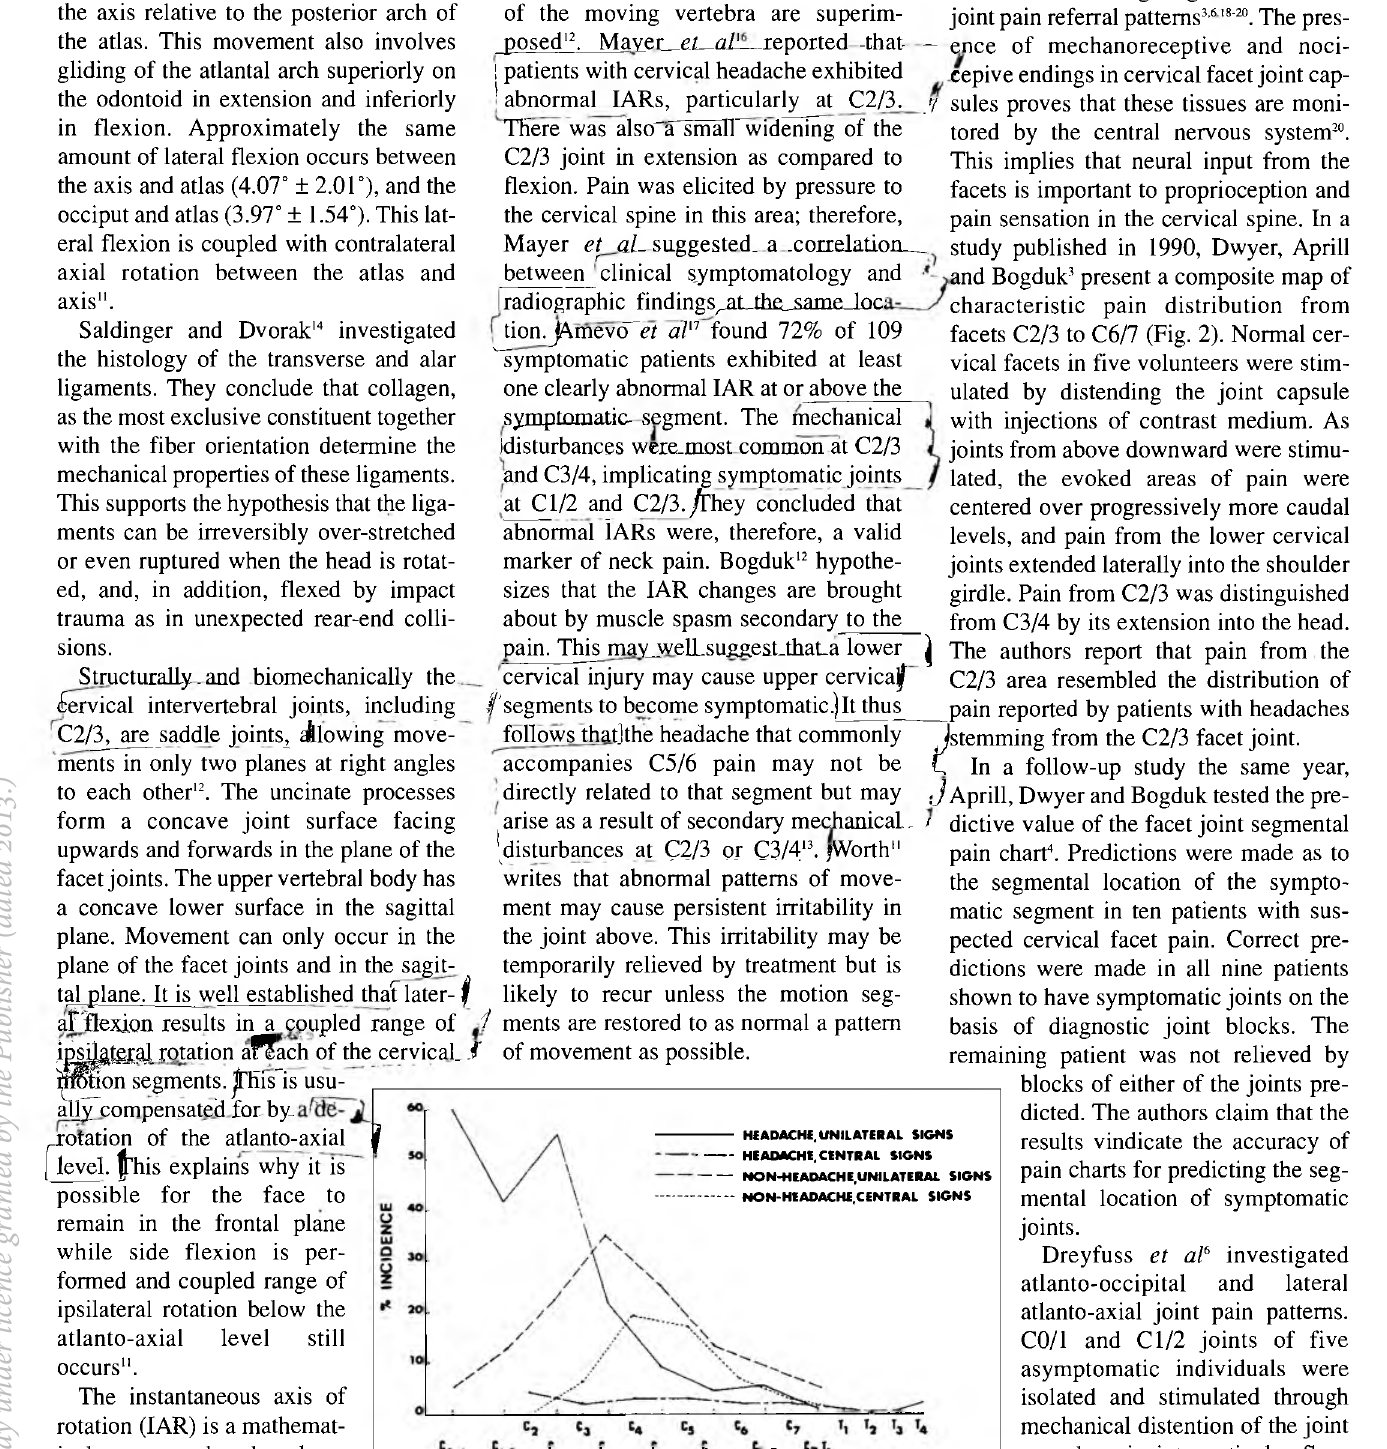
Fig 1: The percentage incidence of positive joint signs found in the left or right apophyseal joints and the central interverte­ bral joints for the 96 headache and the 107 non headache sub­ jects (from Jull GA. Headaches associated with the